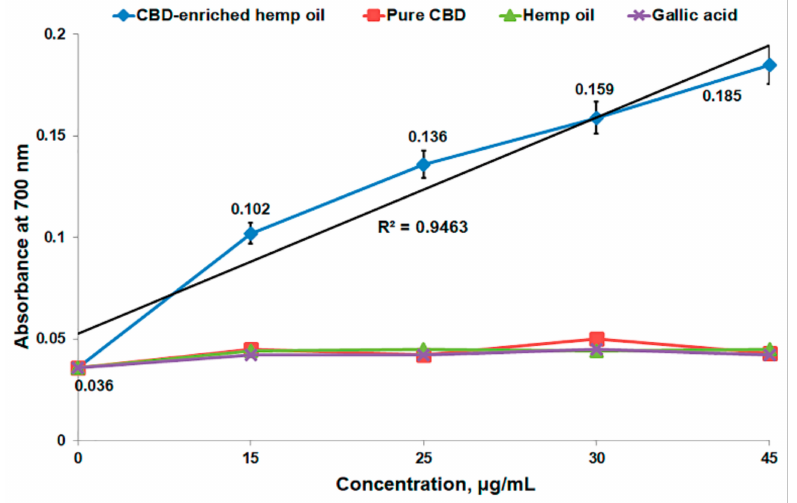
Figure 5. FRAP assay of CBD-enriched hemp oil (15–45 µ g CBD/mL), pure CBD, crude hemp oil and gallic